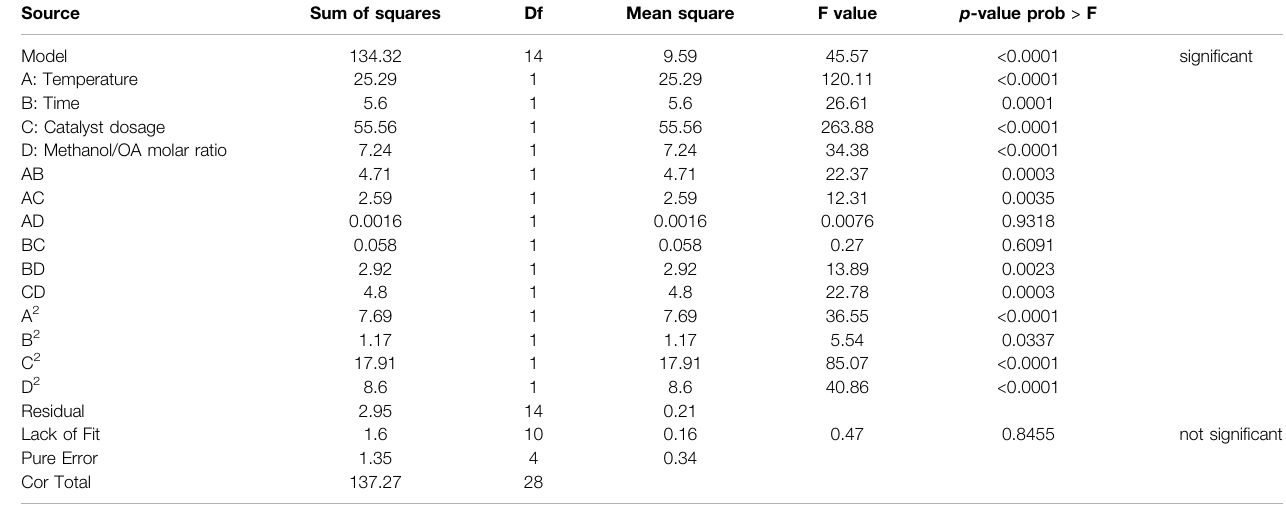
TABLE 3 | ANOVA on the RSM experimental design data.